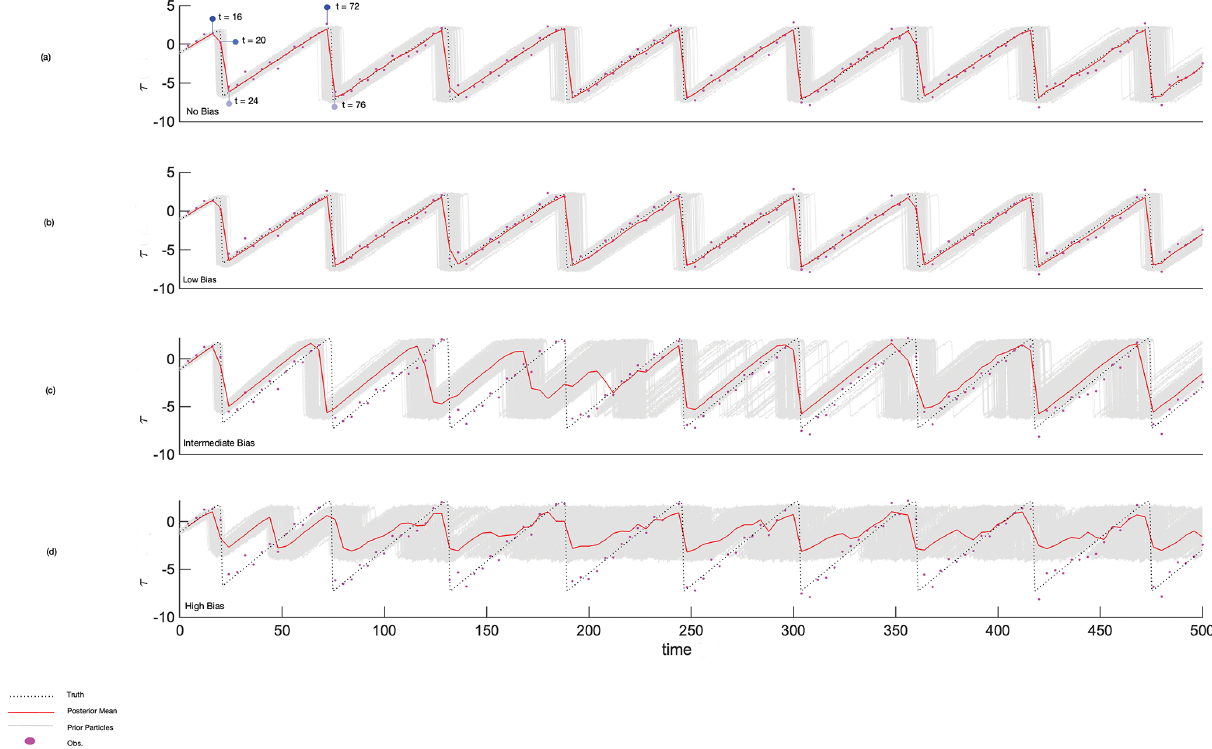
Figure 3. The evolution of 1000 particles along with the posterior mean, observation and truth of state variable τ for state estimation for (a) the case when the model parameter is equal to the true parameter (i.e., a case of no bias; (cid:15) m = 0.70), (b) a small-bias case ( (cid:15) m = 0.72), (c) an intermediate-bias case ( (cid:15) m = 0.60) and (d) a large-bias case ( (cid:15) m = 0.40), when (cid:15) t = 0.70, γ = 0.26 and ξ = 0.18.